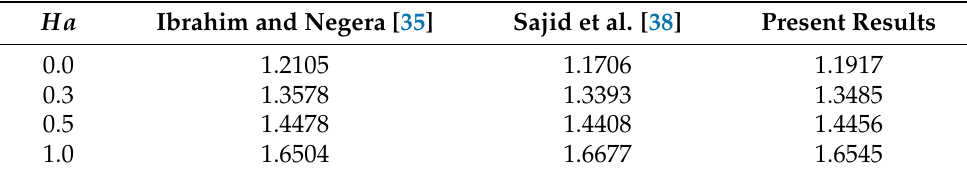
Table 1. The comparative outputs for − f (cid:48)(cid:48) ( 0 ) .